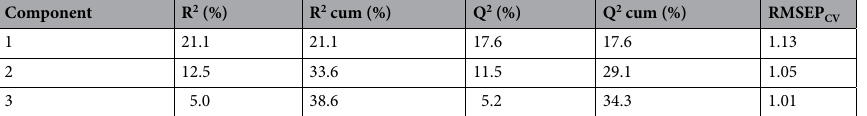
Table 3. Summary of the partial least square regression (PLSR) model for soil organic carbon (SOC) stocks (kg m −2 ) in treeline soils. R 2 explained variability, Q 2 cross-validated R 2 , cum cumulative, RMSEP CV cross- validated root mean square error of prediction.